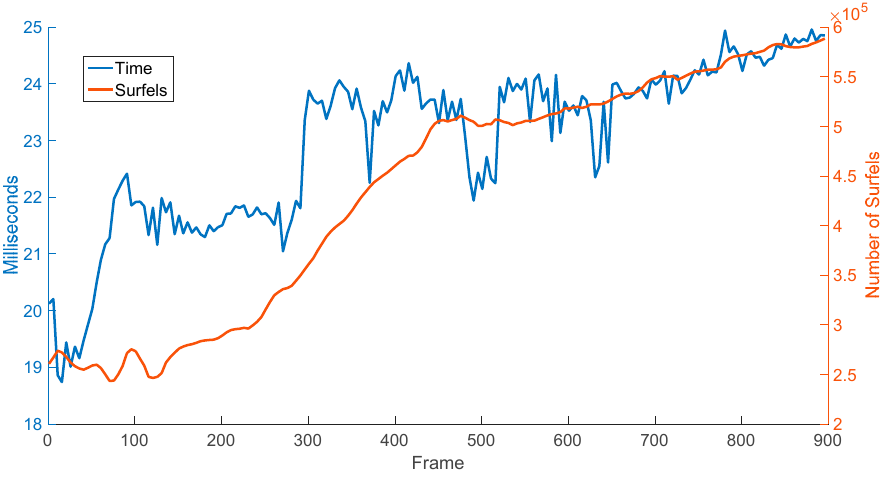
Figure 6. Frame time vs. number of surfels.